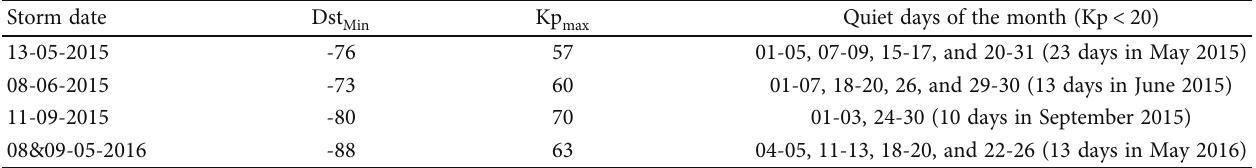
Figure 1: Pixel diagram from 2015. Each line represents a Bartels rotation, the double black circles represent the SSC dates, and the single circles represent the SI. Table 1: Dst and Kp extreme values during geomagnetic storms and month calm